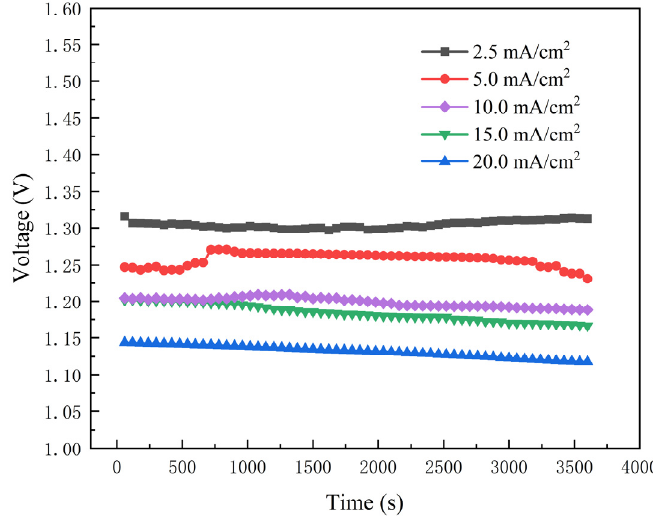
Figure 3. The discharge curves for the aluminum-air battery at different discharge current densities in 4 M NaOH electrolyte for 1 h.